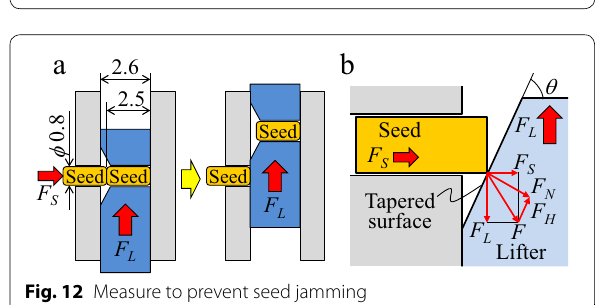
Fig. 12 Measure to prevent seed jamming